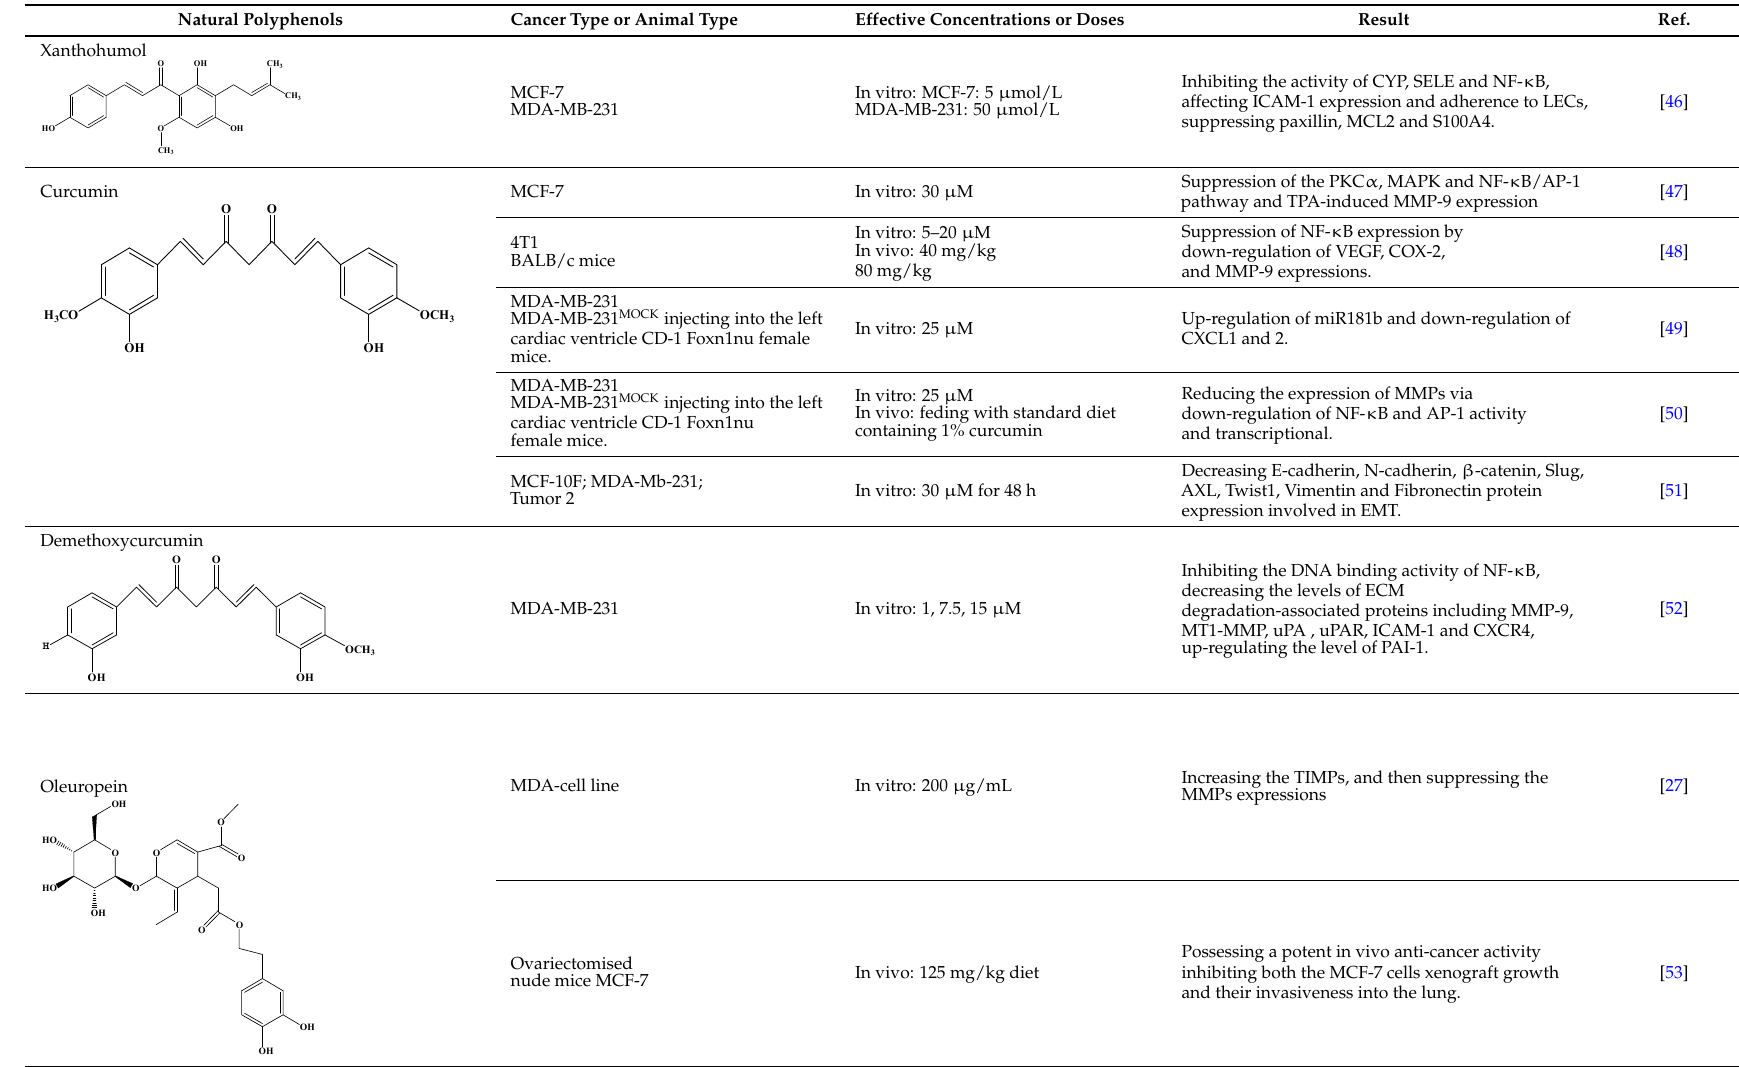
Table 1. Cont. Table 1. Cont. Natural Polyphenols Table 1. Cont. Natural Polyphenols Cancer Type or Animal Type Effective Concentrations or Doses Result